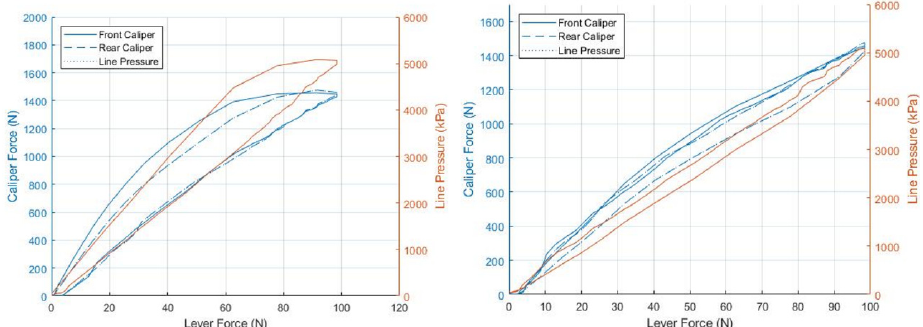
Figure 8. Caliper force as a function of lever force before ( left ) and after ( right ) correcting for caliper load cell sensor hysteresis.